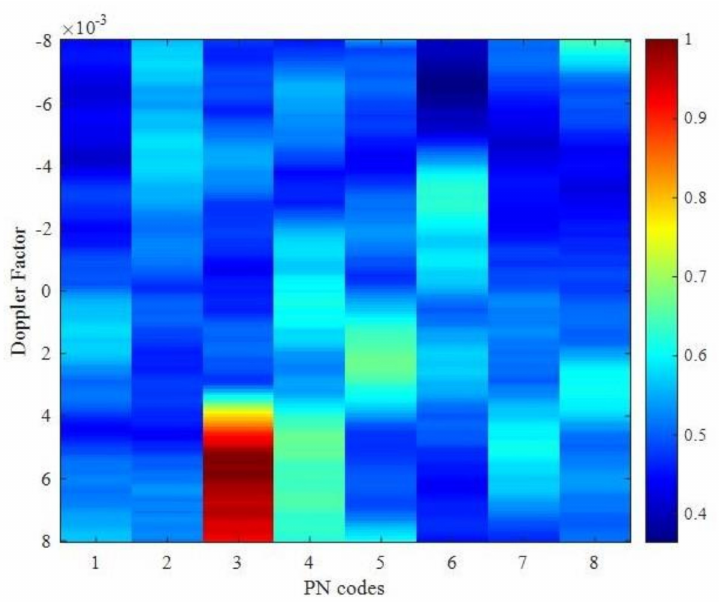
Figure 4. Two-dimensional search